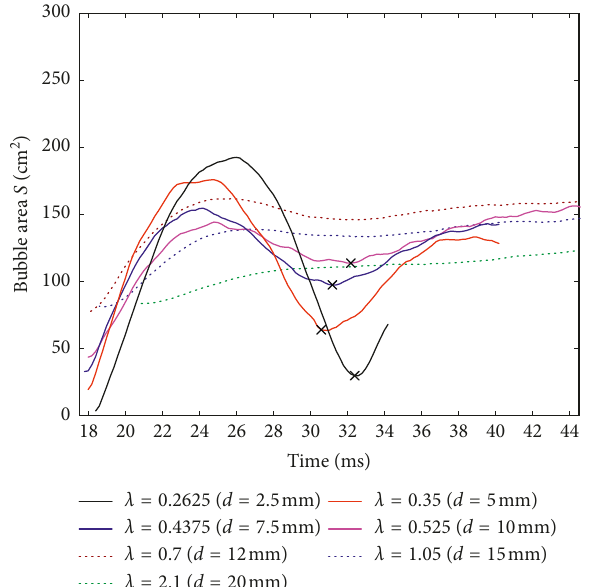
Figure 16: Bubble area with pulsation time in the second pulsation period at different λ.